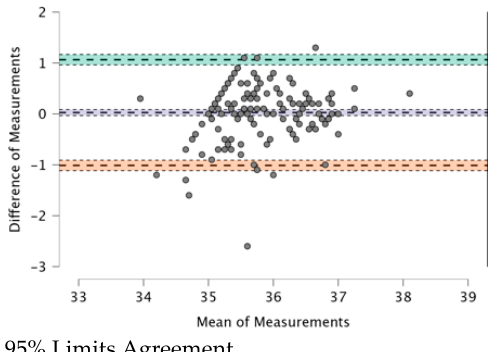
Figure 4. BT–Axillar Electronic TM and BT–Axillar Gallium TM.